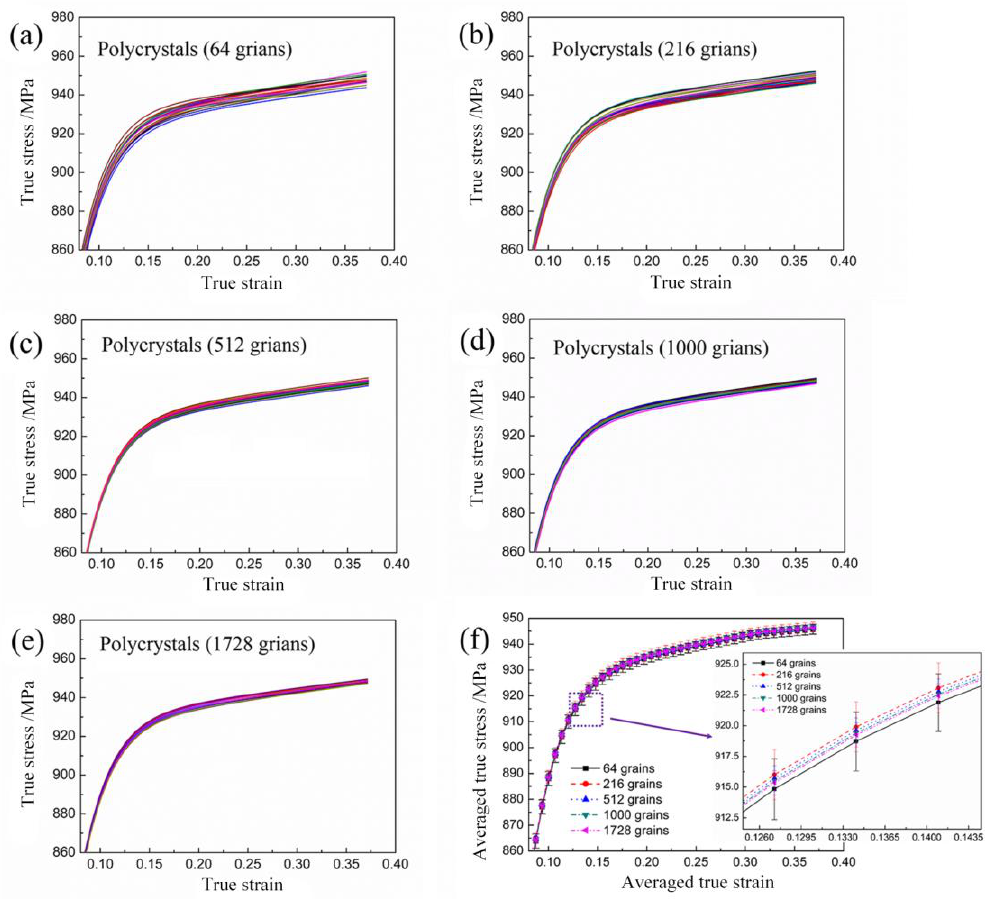
Figure 6. Simulated stress-strain curves from 20 realizations of uniaxial compression deformation of voxel model with various initial orientations: ( a ) 64 grains; ( b ) 216 grains; ( c ) 512 grains; ( d ) 1000 grains; ( e ) 1728 grains; ( f ) the averaged stress-strain curves corresponding to different grain